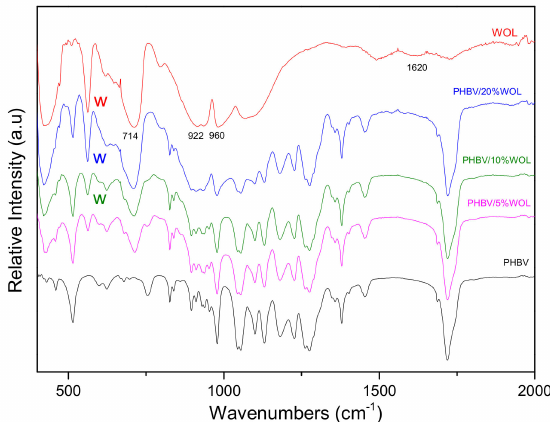
Figure 4. FT-IR spectra of WOL powder and neat PHBV, PHBV / 5%WOL, PHBV / 10%WOL and PHBV / 20%WOL